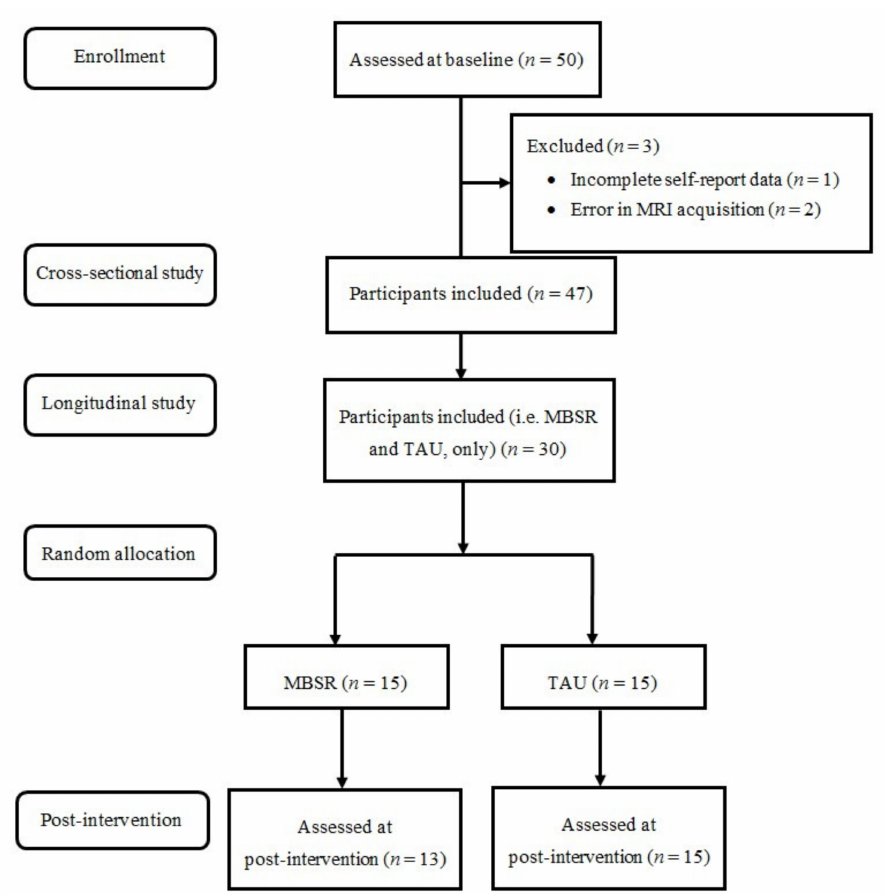
Figure 1. Flowchart of the study. MBSR: Mindfulness-based stress reduction; TAU: